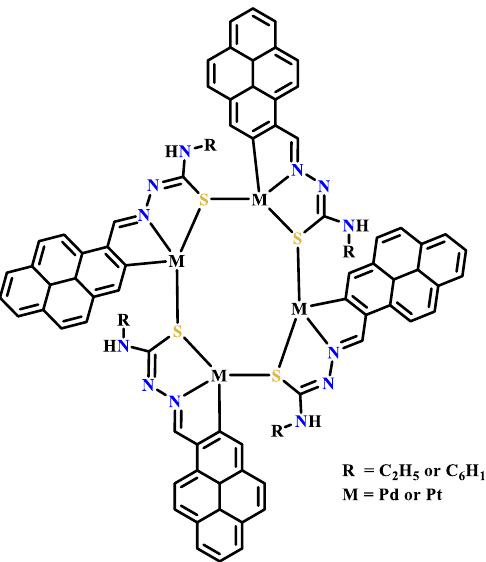
Figure 54. The novel symmetric tetranuclear Pd(II)/Pt(II) complexes of pyrene hydrazone with ( N -ethyl/phenyl)-substituted thiourea as a side chain.